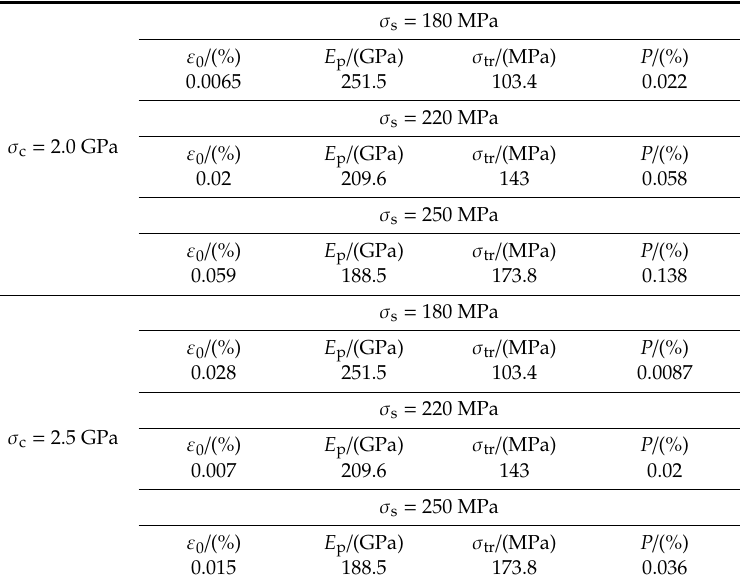
Figure 12. ( a ) The tensile stress–strain curves; ( b ) the tangent modulus versus strain curves; ( c ) the interface debonding fraction versus stress curves; and ( d ) the broken fibers fraction versus stress curves of SiC/SiC composite for conditions without stochastic loading and with stochastic loading of σ s = 180, 220 and 250 MPa when σ c = 2.5 GPa. Table 5. The effect of the fiber strength ( σ c = 2.0 and 2.5 GPa) on tensile stress–strain curve, tangent modulus, interface debonding fraction and broken fiber fraction of SiC/SiC composite subjected to stochastic loading of σ s = 180, 220 and 250 MPa.